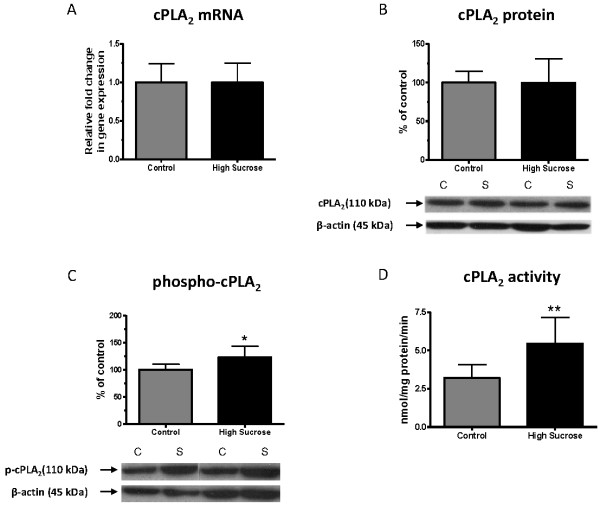
mRNA, protein and activity of cPLA2and phosphorylated (phospho)-cPLA2protein in brain of rats fed the control or high-sucrose diet for 8 weeks.A) cPLA2 (IVA) mRNA, B) cPLA2 (IVA) protein, C) phospho- cPLA2 (IVA) protein and D) cPLA2 activity. Data are expressed as the relative level of the cPLA2 normalized to the endogenous control (β-globulin) using the ΔΔCT method. Protein level is the ratio of optical density of cPLA2 to β–actin, expressed as percent of control. Values are mean ± SD (n = 8 for both groups). *p < 0.05, **p < 0.01 by unpaired t-test.